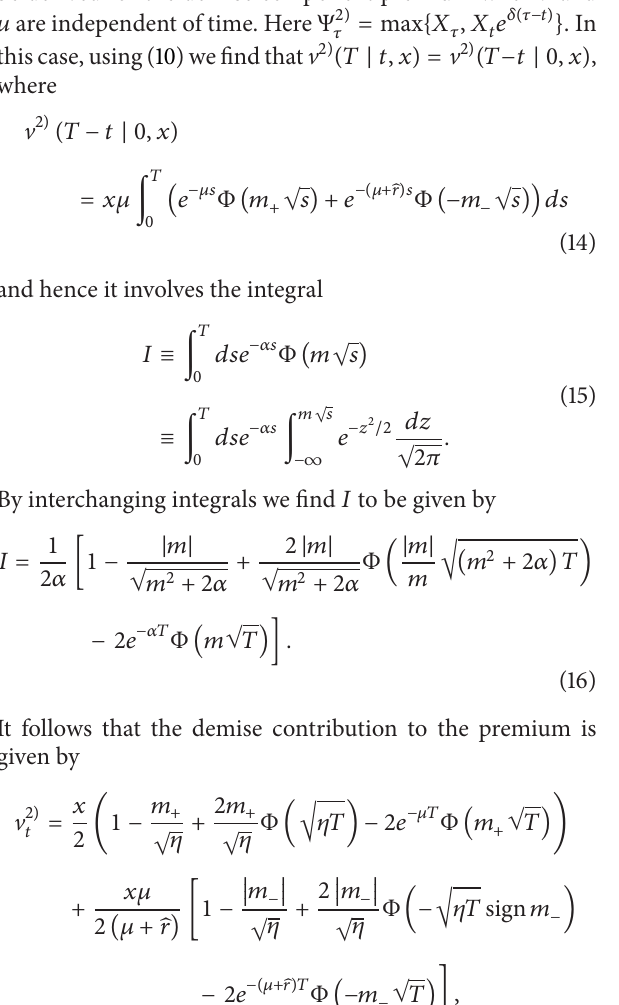
Figure 1: Mortality premium as a function of time to maturity given in years corresponding to a constant annual interest rate 𝑟 = 4.5 %. Other parameters are 𝑥 = 5 , 𝜎 = 25 %, 𝜇 = 0.015 (thick solid line) and 𝑥 = 5 , 𝜎 = 15 %, 𝜇 = 0.025 (thin